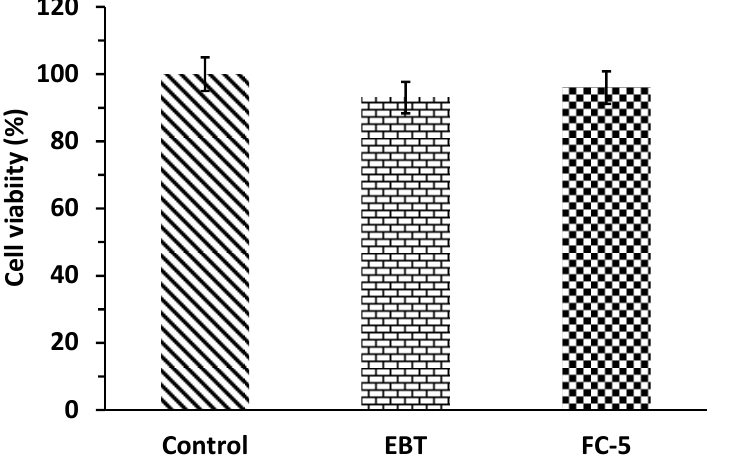
Figure 11. Cell viability of human buccal epithelium cell lines (TR146) after exposure to pure EBT and FC-5 micelle loaded films.